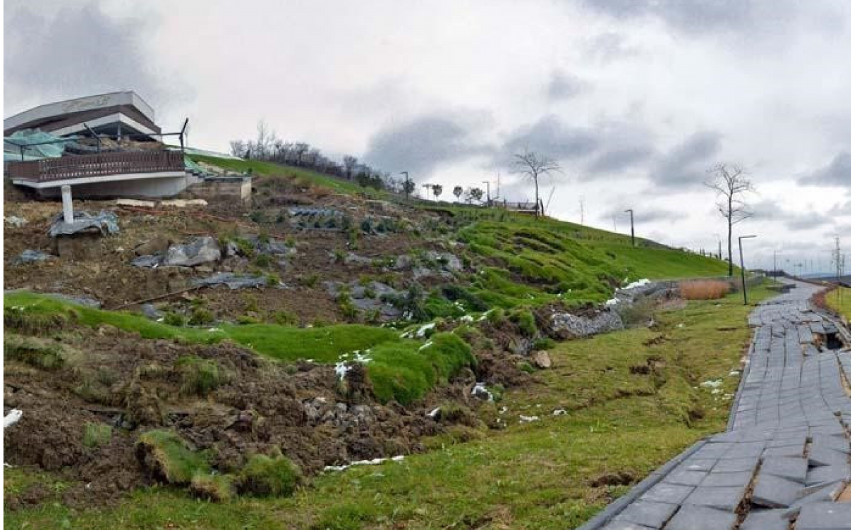
Figure 9. Perspectives over the landslide from Ciuperca Hill in Oradea (12–13 November 2016). Source: